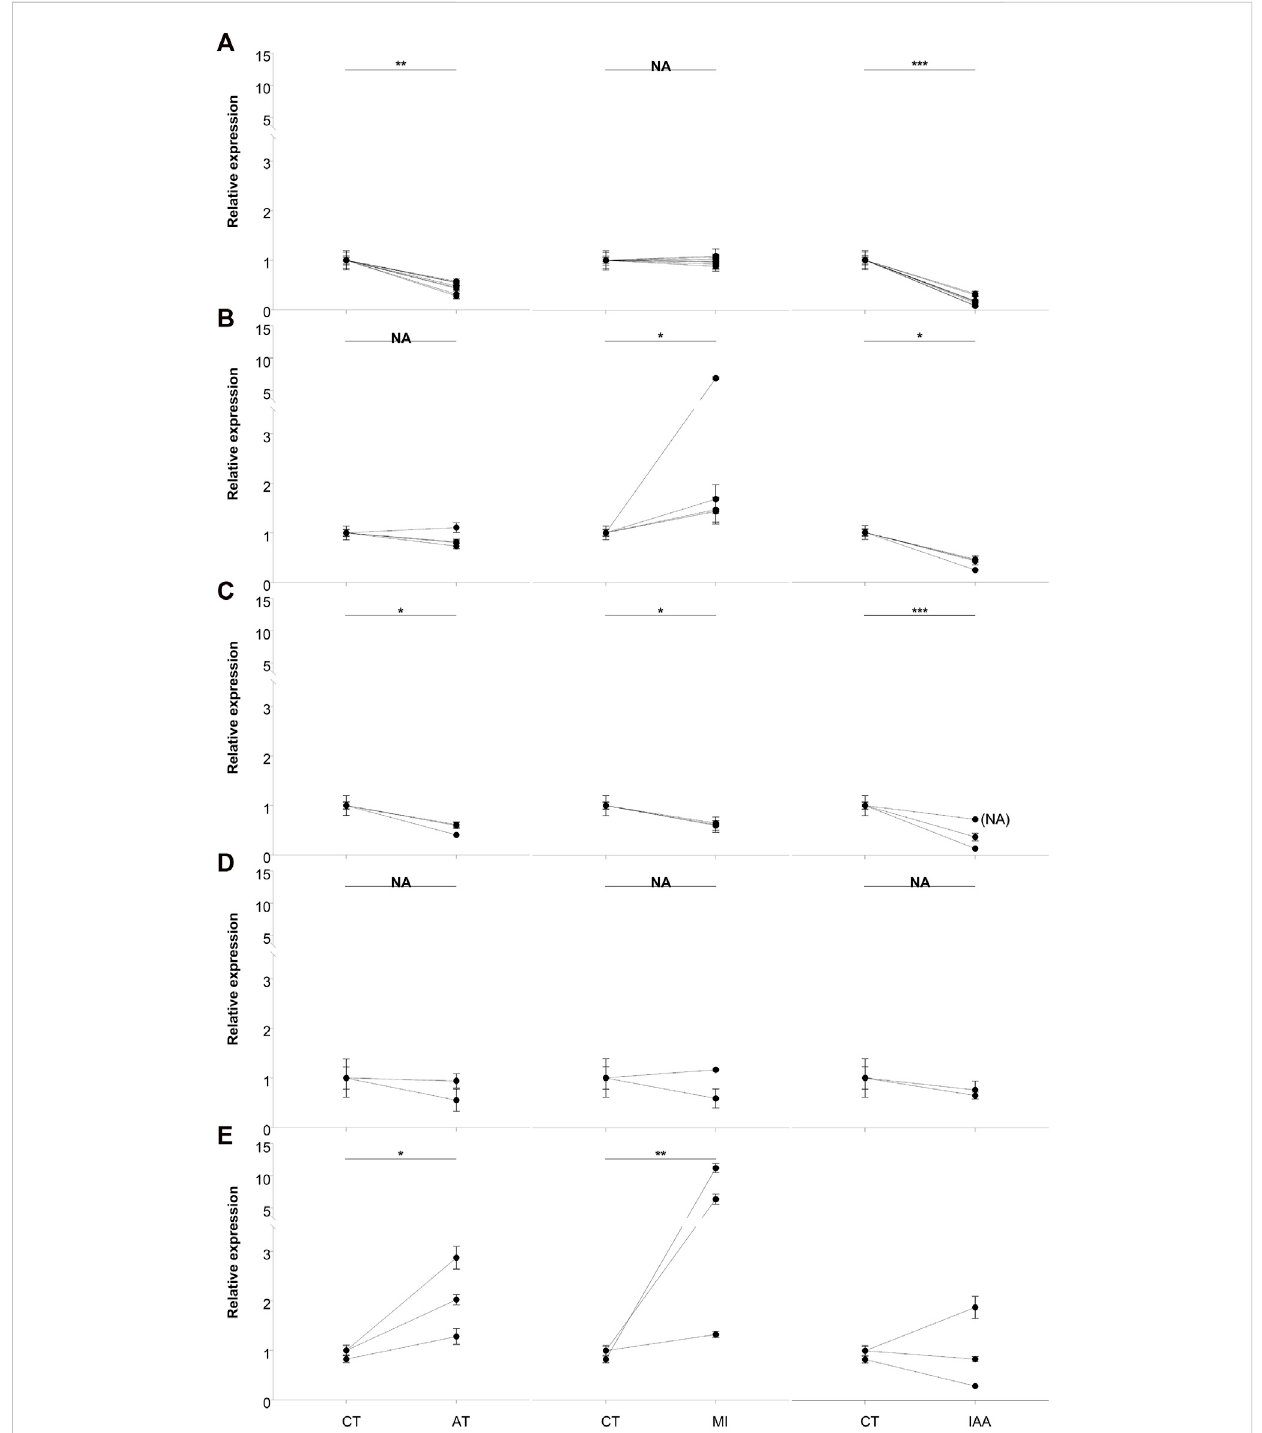
FIGURE 6 qRT-PCR analysis of the top 20 most signi fi cantly expressed genes. Based on the expression pro fi les, DEGs were grouped as fl ow: (A) down- regulated in AT and IAA; (B) upregulated in MI but down-regulated in IAA; (C) down-regulated in all groups; (D) no changed in all groups and (E) the remained genes. β -actin was used to normalize the data, which are shown as mean ± standard error; the mean was obtained from three independent repeats. The 2 − ΔΔ CT method was adopted to calculate the relative expression level. The statistical difference relative to the control (CT) group, determined with an unpaired t -test, is shown via GraphPad Prism8. Asterisks indicates statistically signi fi cant differences (* = p < 0.05; ** = p < 0.01; *** = p < 0.001). (CT: treated with sterilized water as control treatment; AT: treated with 5% kanamycin antibiotic; MI: treated with 108/mL M. robertsii conidia suspension at 48-h; IAA: treated with 5% kanamycin, then treated with 108/mL M. robertsii conidia suspension at 48